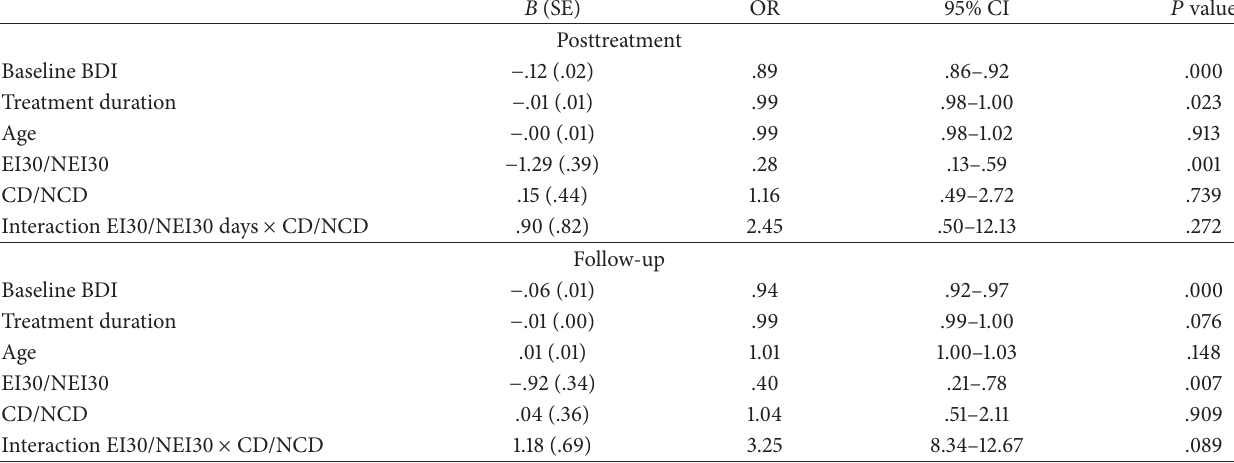
Table 6: Binary logistic regression analyses of the covariates/factors associated with treatment outcome at posttreatment and follow-up for the early improvement definition after 30 days